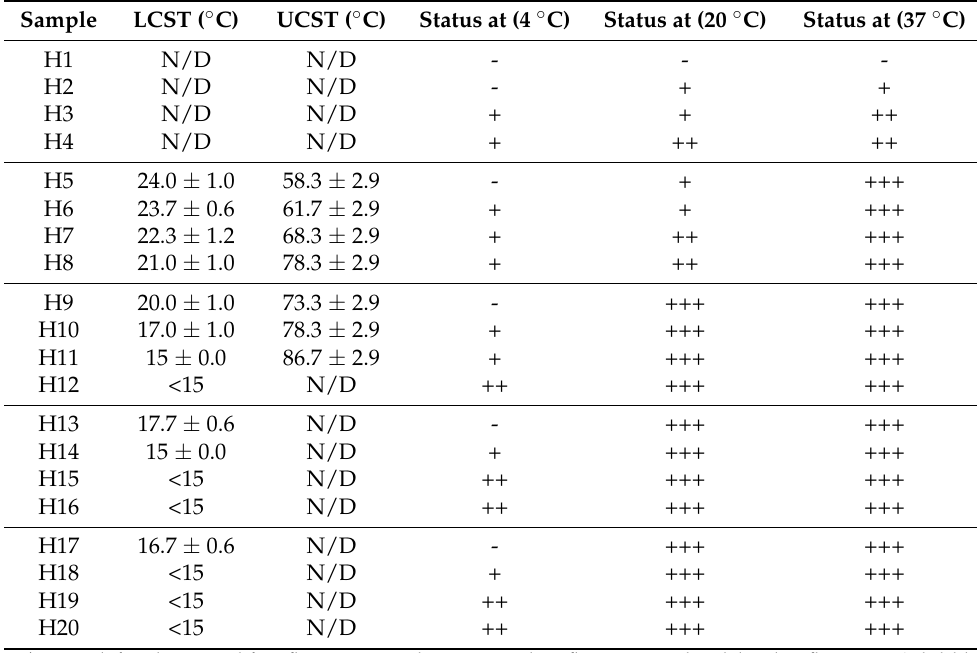
Table 2. SGTT and flow behavior of the thermo-responsive cellulose